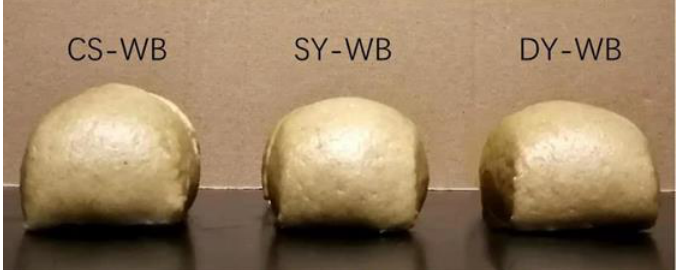
Figure 5. Photographs of whole wheat steamed bread. Note: CS-WB—whole wheat steamed bread fermented by compound starter; SY-WB—whole wheat steamed bread fermented by Saccharomyces cerevisiae ; DY-WB—whole wheat steamed bread fermented by commercial dry yeast. Table 5. Textural properties of whole wheat steamed bread.